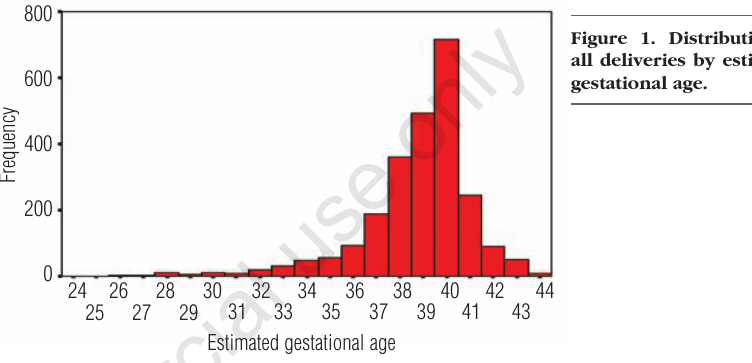
Figure 1. Distribution of all deliveries by estimated gestational